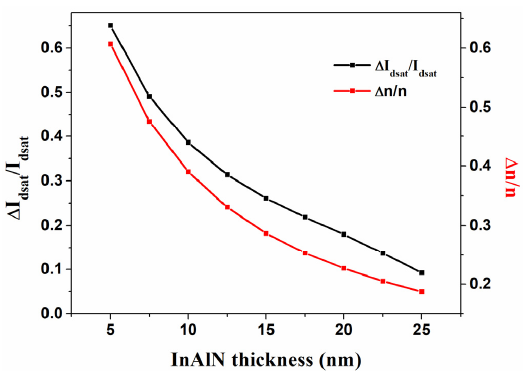
Figure 6. The change rates of the saturation drain current and the 2DEG concentration of the HEMT with different InAlN barrier thicknesses.